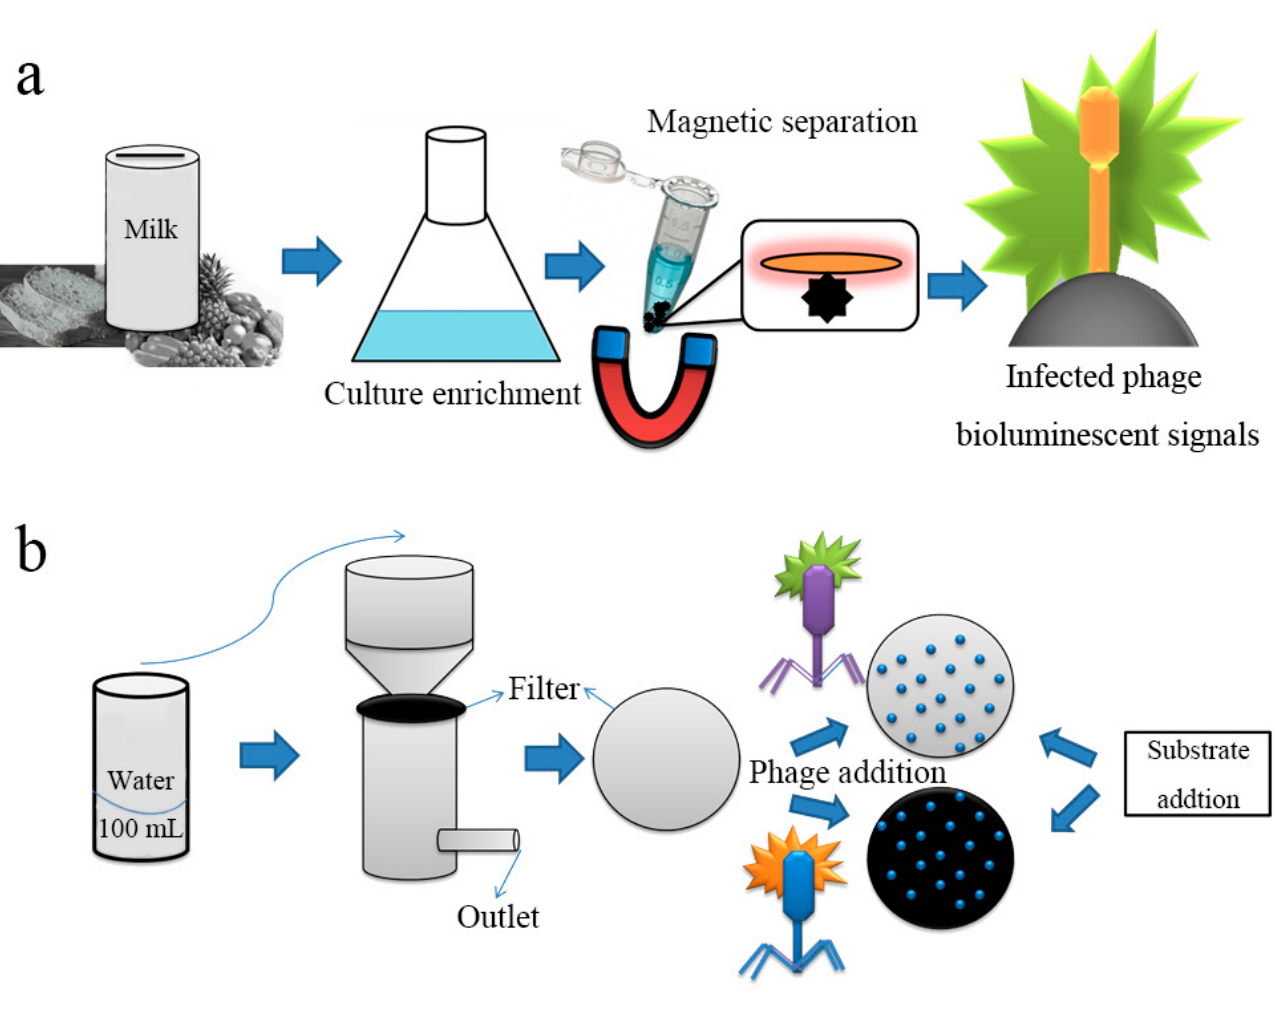
Figure 3. Schematic representation of phage-based bioluminescent detection. ( a ) Pathogens in the contaminated food sample were detected by CBD-MS based genetically engineered phage with readout of bioluminescence signal; ( b ) pathogen in contaminated water detected by filter medium based recombinant phage infection and protein expression on substrate addition